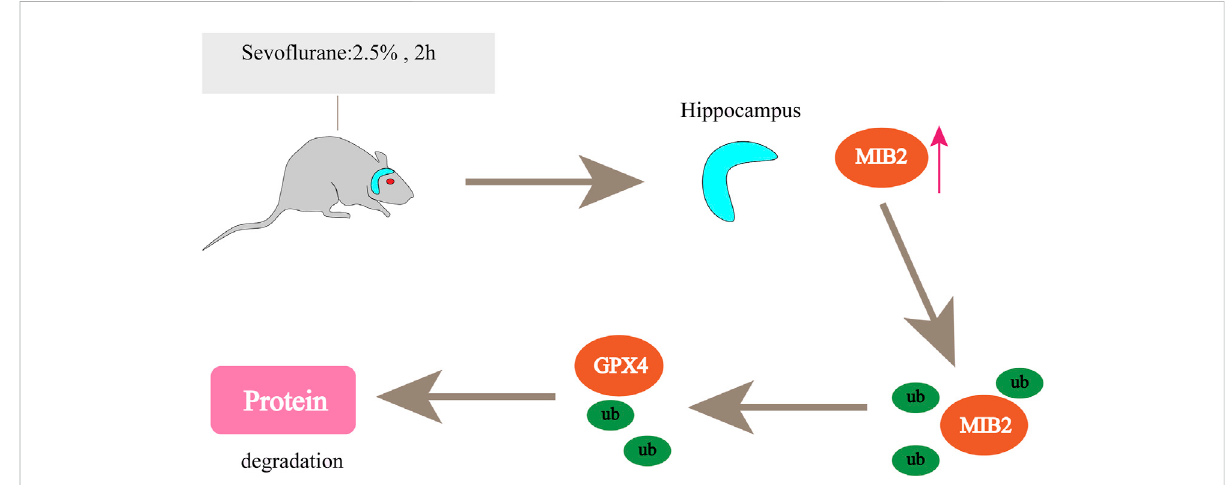
FIGURE 4 Sevo fl uraneincreases MIB2 expression in themouse hippocampus.MIB2 candirectly bind to GPX4, regulateitsstability and ubiquitination,and regulate ferroptosis in mouse hippocampal neurons. “ ↑ ” represents